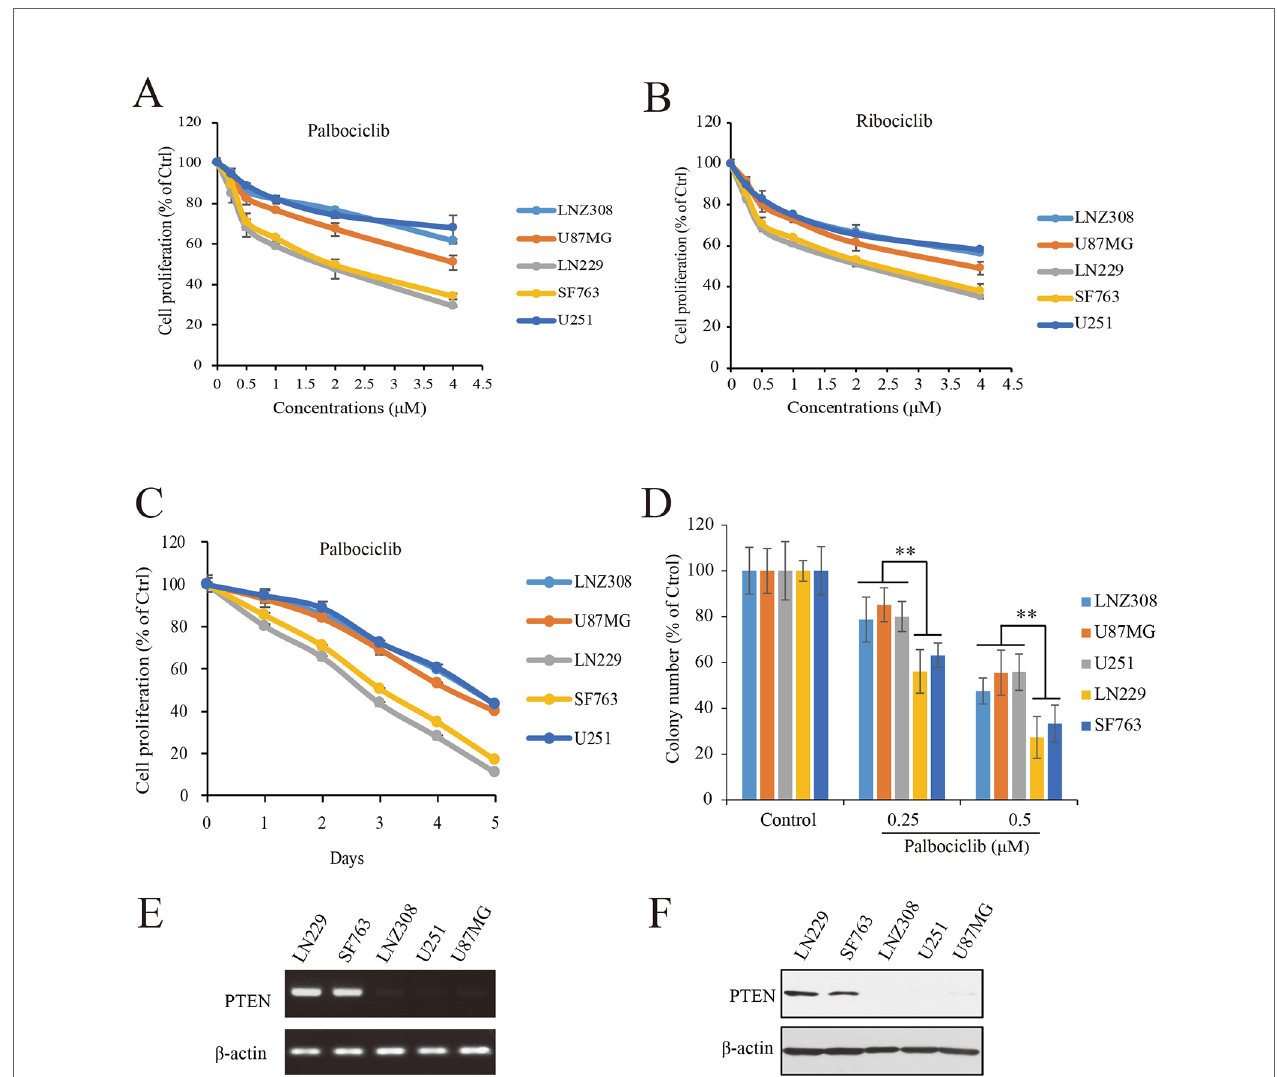
FIGURE 2 | Effects of CDK4/6 inhibitor on various GBM cells with different PTEN status. (a , B) . Cells were seeded in 96-well plate (3,000 cells/well) and treated with indicated concentrations of palbociclib (a) and ribociclib (B) for 48 h. Cell proliferation was assessed by MTT assay as described in Materials and Methods . Data are expressed as mean ± SD. (C) Palbociclib suppressed GBM cells in a time-dependent manner. Cells were prepared as described above and treated with palbociclib (0.5 μM) for indicated times. Cell proliferation was assessed by MTT assay as described in Materials and Methods . Data are expressed as mean ± SD. (D) Effects of palbociclib on colony formation in GBM cells with different PTEN status. Data are show as means ± SD (** P 0.01, t -test, n = 3). (E) PTEN expression profile at mRNA level in the tested GBM cell lines. (F) PTEN expression profile at protein level in the tested GBM cell lines.